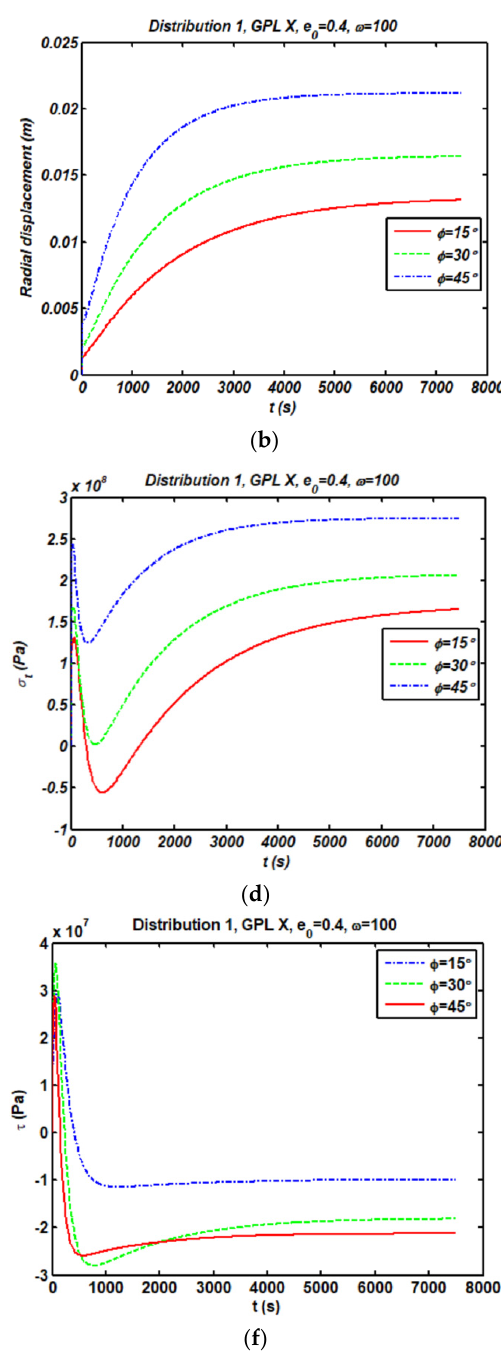
Figure 5. Influence of semi-vertex angle on the transient temperature ( a ), radial displacement ( b ), and stress state ( c – f ) for a center point of truncated cone (D1-GPL X; e 0 = 0.4; γ GPL = 0.01; ω = 100 rad/s).